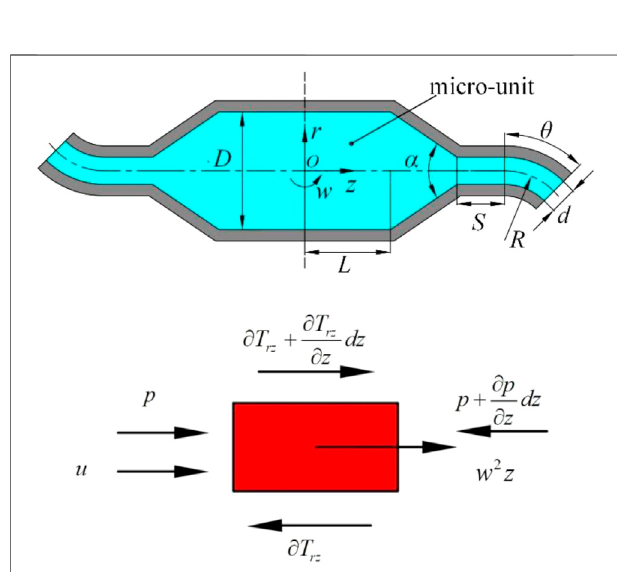
FIGURE 4 | Rotating spinning model. (A) One-dimensional fl ow of spinning solution. (B) Force diagram of micro-unit.